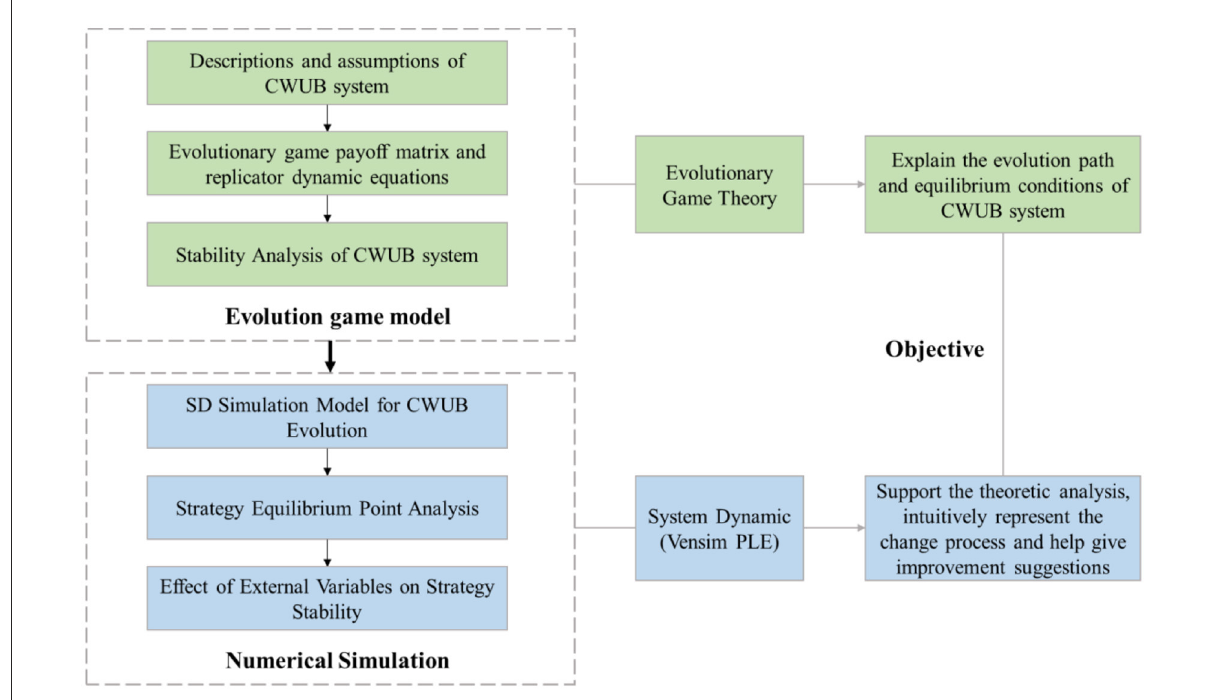
FIGURE1 The framework of research methodology.